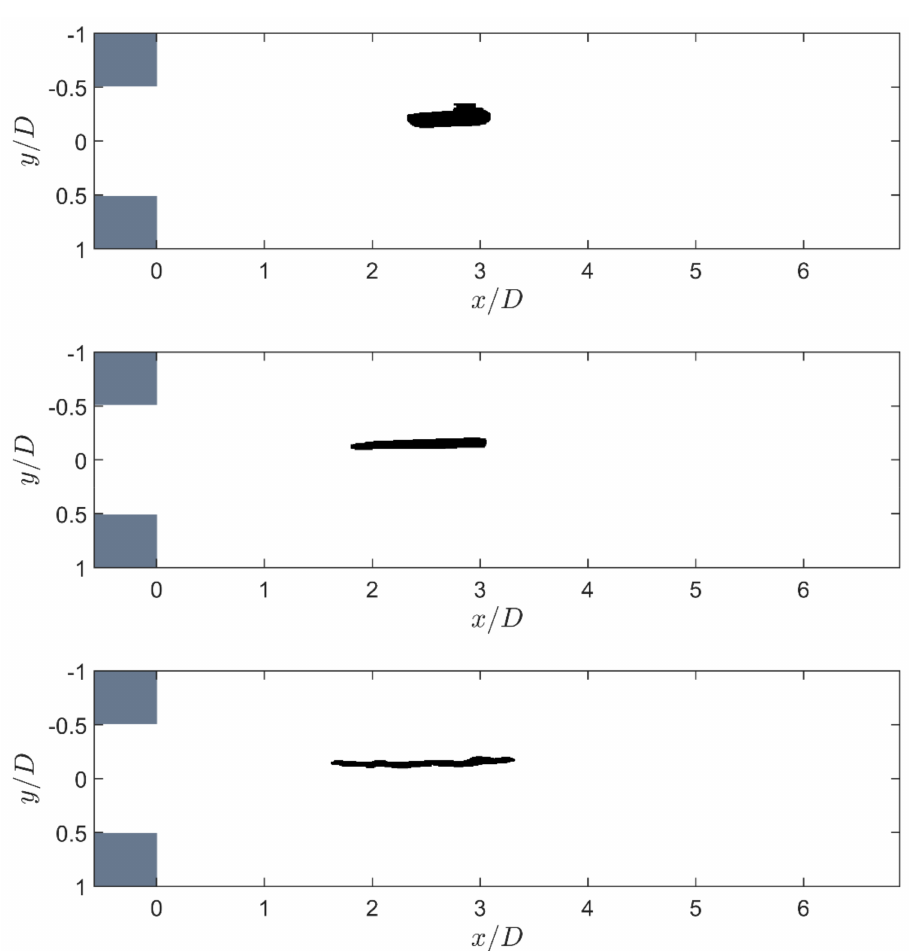
Figure 23. Comparison of the droplet elongation behind the orifice at different viscosity ratios at Re = 2000; top : λ = 0.3, middle : λ = 3.0, bottom : λ =